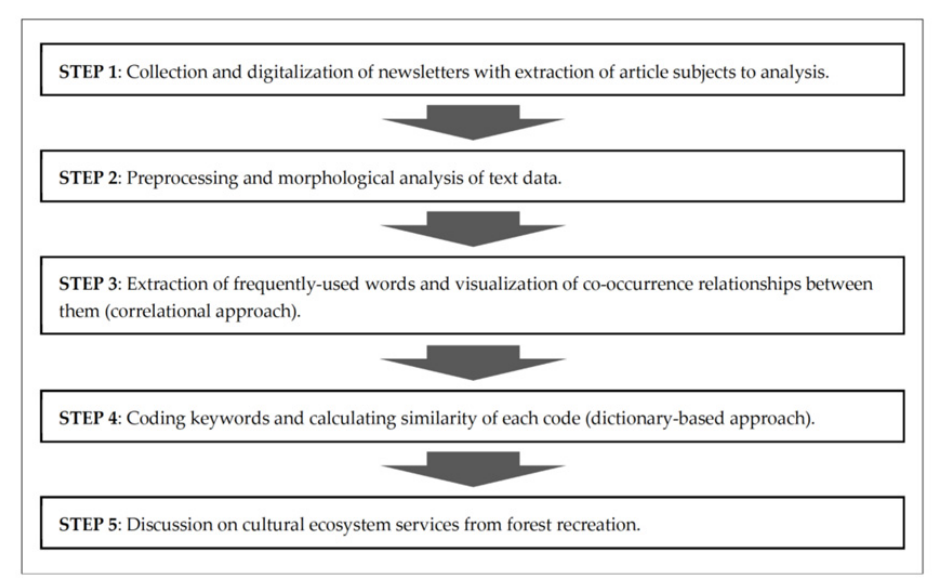
Figure 4. Flowchart showing the steps of this